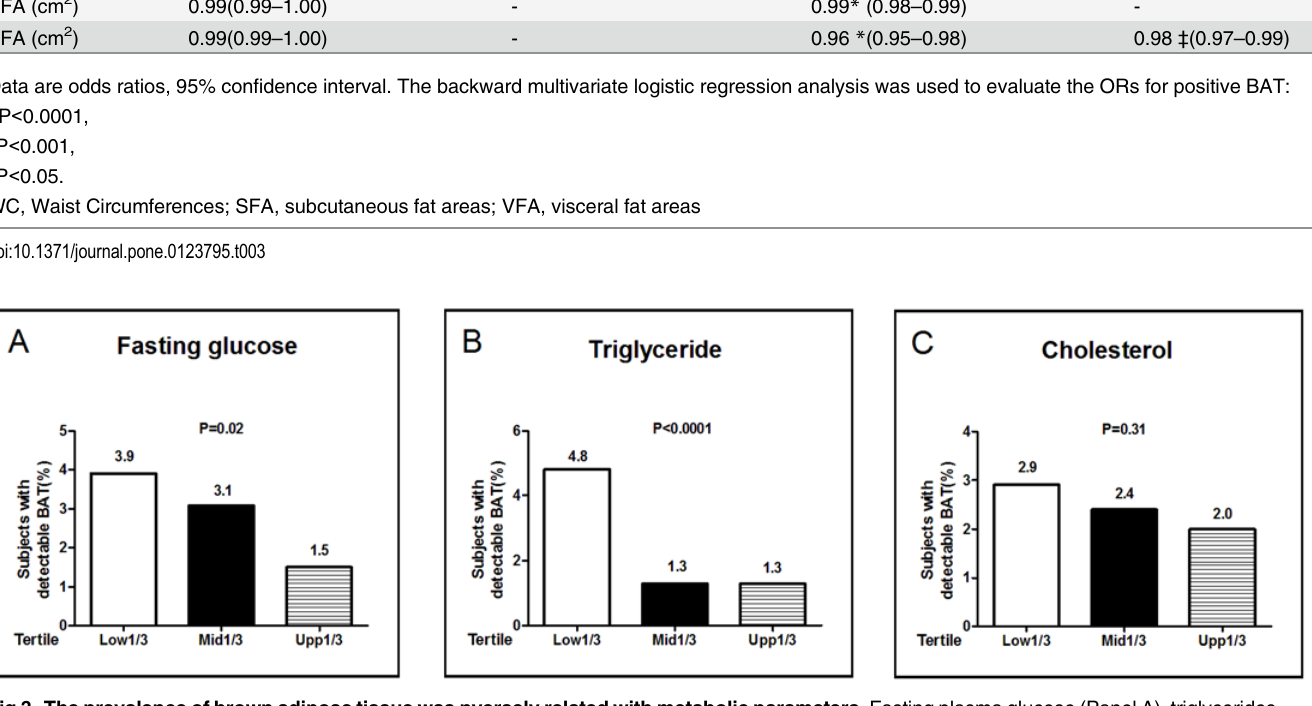
Fig 3. The prevalence of brown adipose tissue was nversely related with metabolic parameters. Fasting plasma glucose (Panel A), triglycerides (Panel B) and total cholesterol (Panel C) levels were divided into thirds. The percentage of patients in each subgroup who had detectable BAT was shown, and the P values for trend were calculated by using Mantel-Haenszel Chi-Square